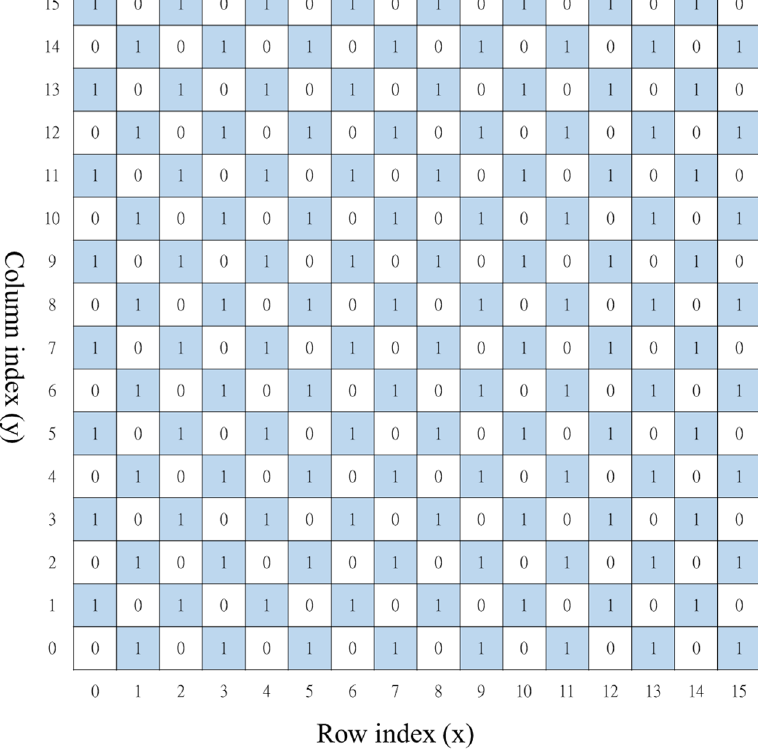
Figure 5. Binary digital table BD.